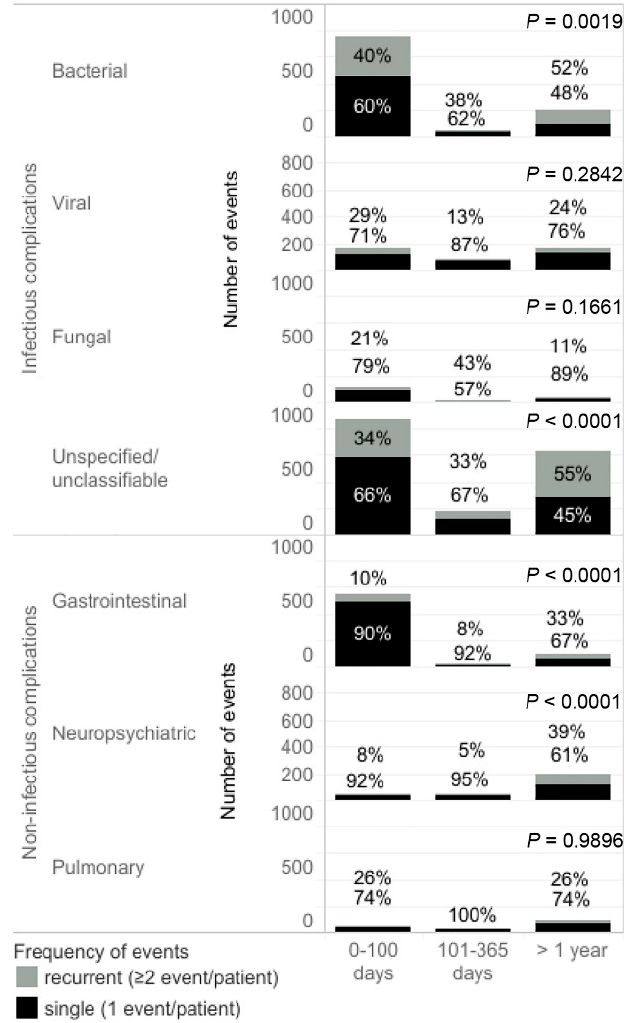
Figure 1. The number of complication events in periods of observation after the first transplant. Single complication indicates that the event occurred once in one patient. Recurrent complication indicates that the event occurred twice or more frequently in one patient during the observation period. p -values were calculated for proportion comparison between events occurring within 100 days immediately after the transplant and >1 year after the